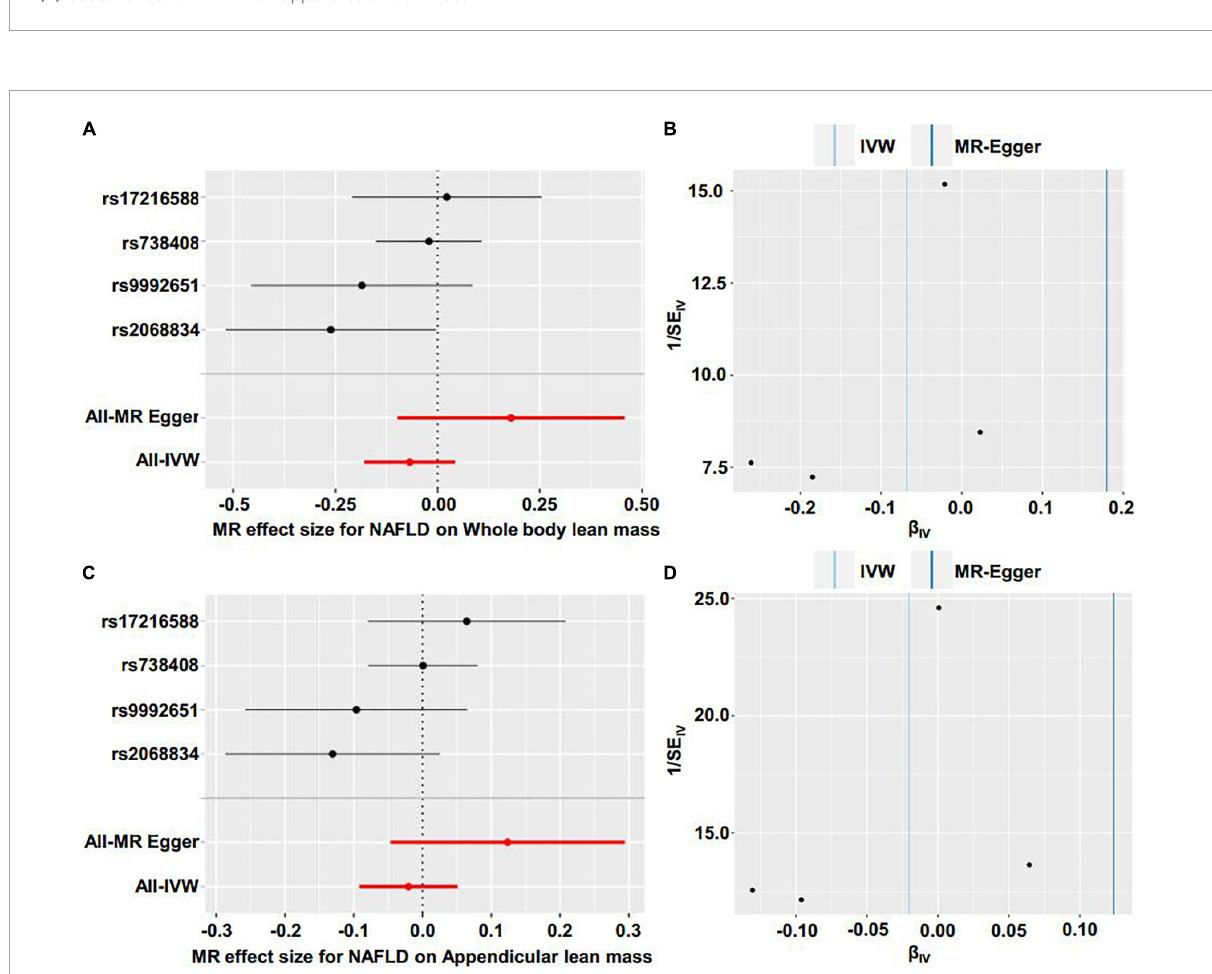
FIGURE5 Forest plot and funnel plot of the causal effect of NAFLD on lean body mass. (A) Forest plot of the causal effect of NAFLD on whole body lean mass. (B) Funnel plot of the causal effect of NAFLD on whole body lean mas. (C) Forest plot of the causal effect of NAFLD on appendicular lean mass. (D) Funnel plot of the causal effect of NAFLD on appendicular lean